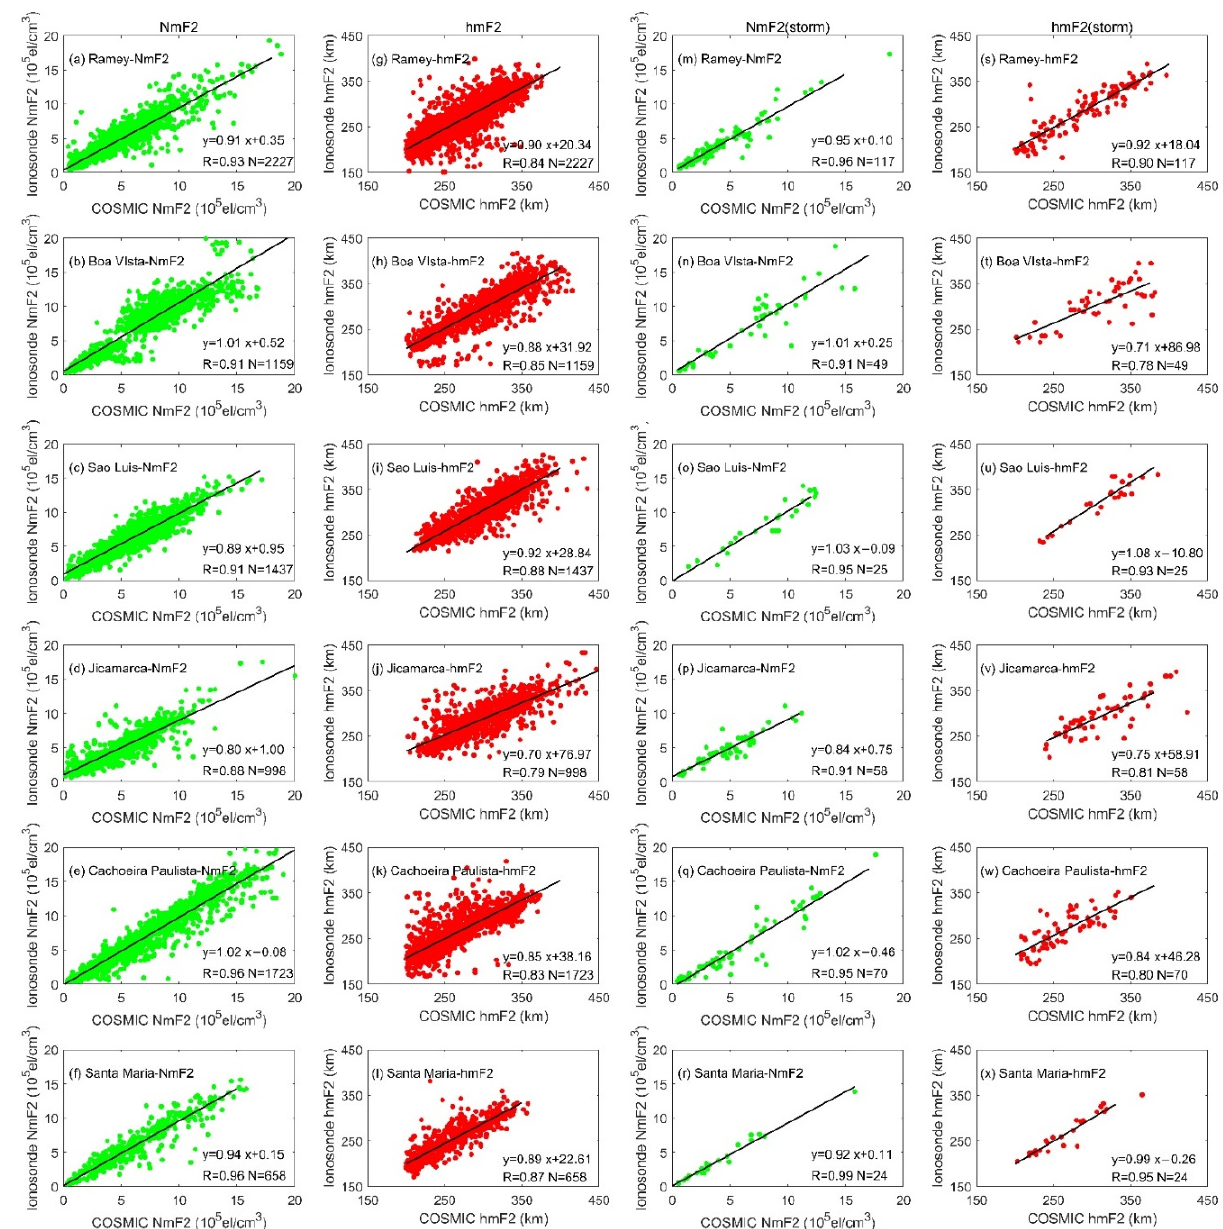
Figure 4. Scatter plots of N m F 2 (green dots) and h m F 2 (red dots) obtained from COSMIC-2 observations and ionosonde measurements at each station. The black lines are the trends of fitting functions; R is the correlation coefficient; and N is the number of data pairs. The first two columns ( a – l ) and the last two columns ( m – x ) are for quiet and geomagnetic storm conditions, respectively.